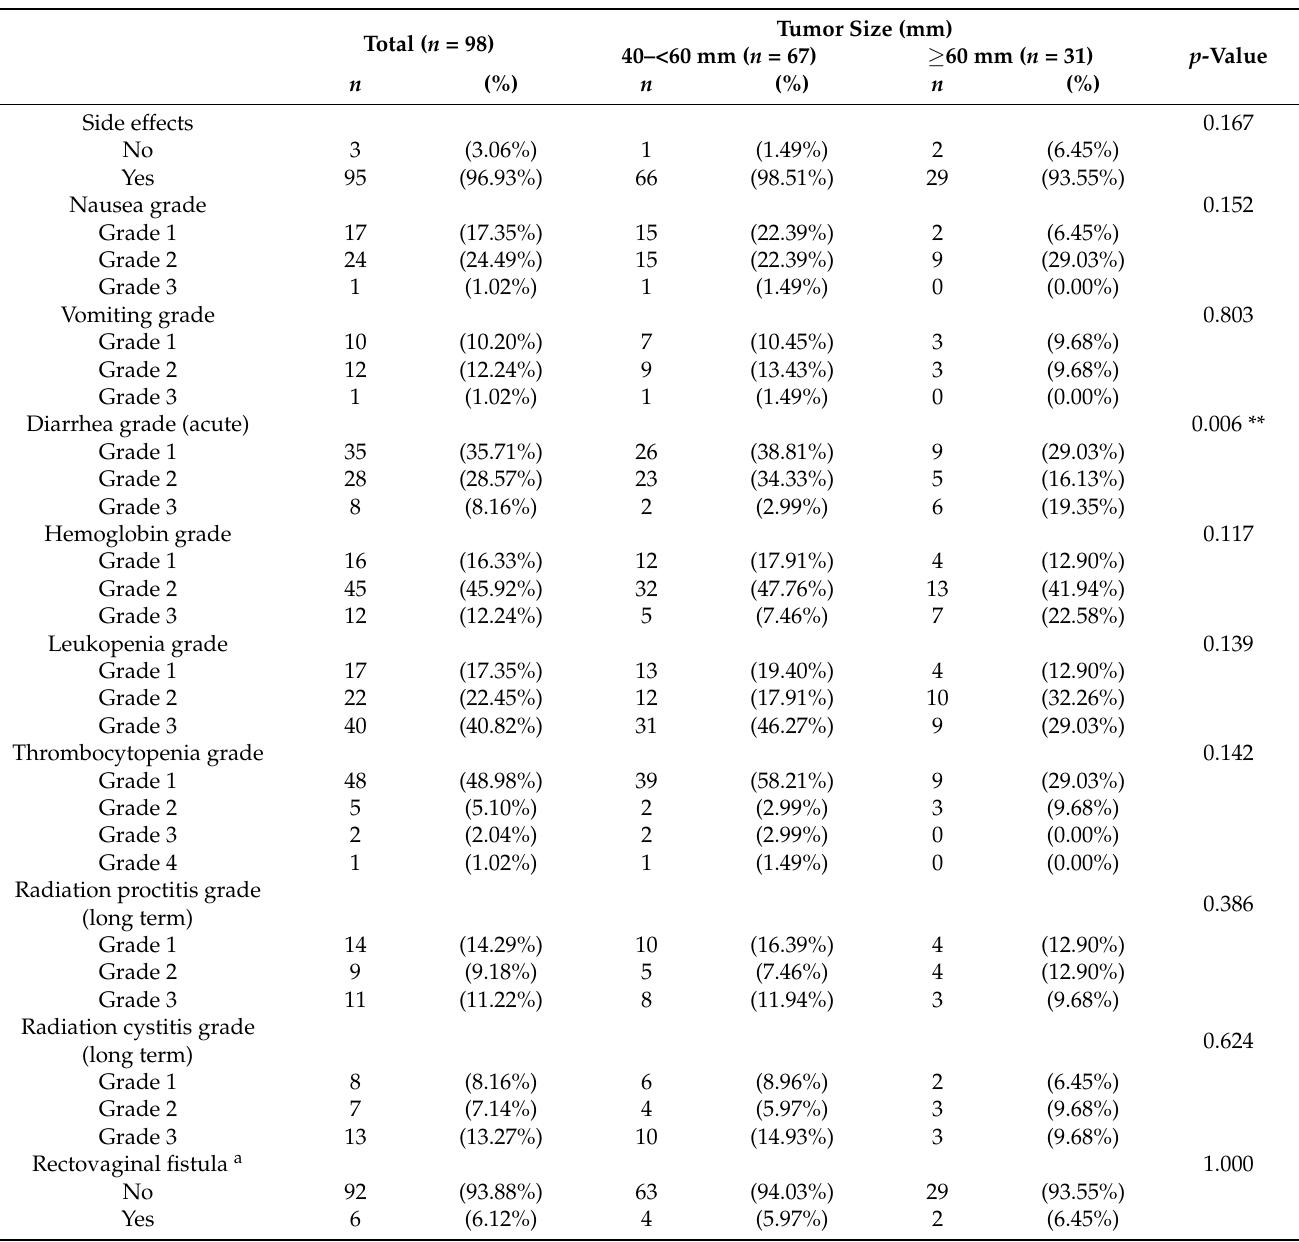
Table 5. Acute and late toxicity of intensity-modulated radiotherapy (IMRT) with concurrent chemotherapy ( n =